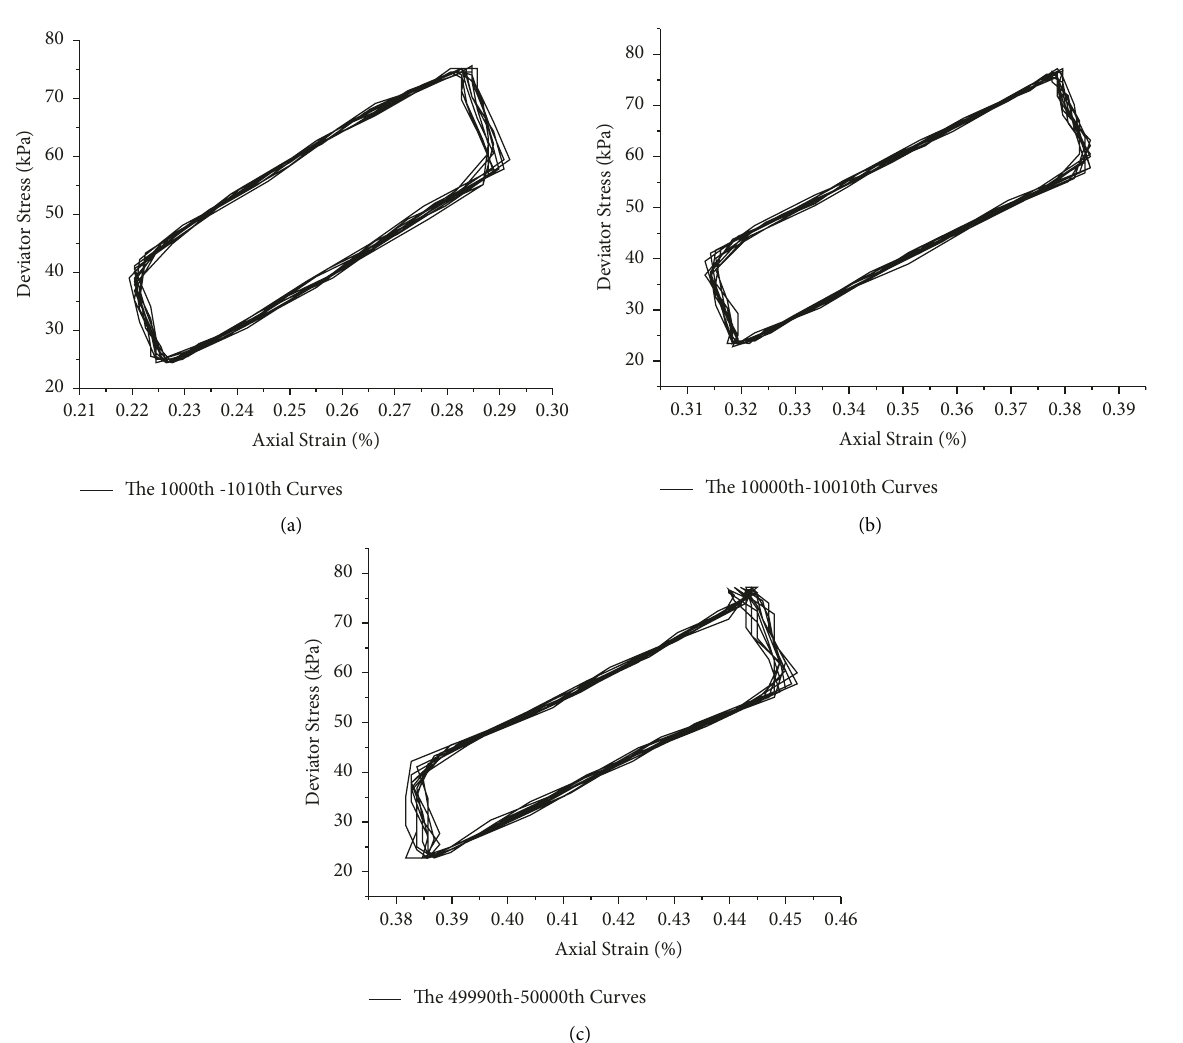
� 25 kPa, | σ � 75kPa. (a) The 1000 th –1010 th curves. (b) The 10000 th –10010 th curves. (c) The 3 1 – σ 3 | max